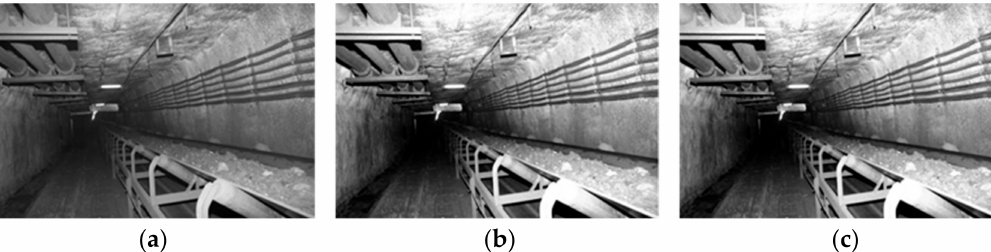
Figure 3. Comparison of histogram equalization results. ( a ) Original image; ( b ) software processing result; ( c ) FPGA processing